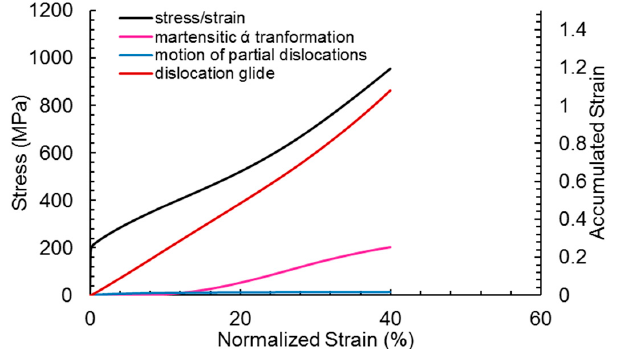
Figure 15. The comparison of calibrated numerical simulation model results with the experimental results of cast X8CrMnNi16-6-6 steel (reprinted with permission from [43], MDPI, 2020).